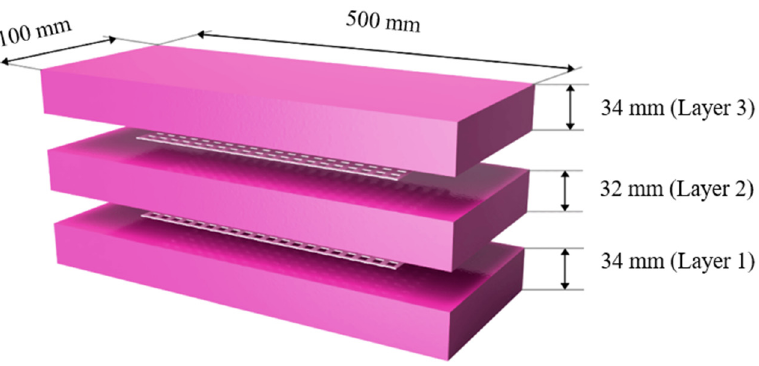
Figure 4. GFM insertion location.